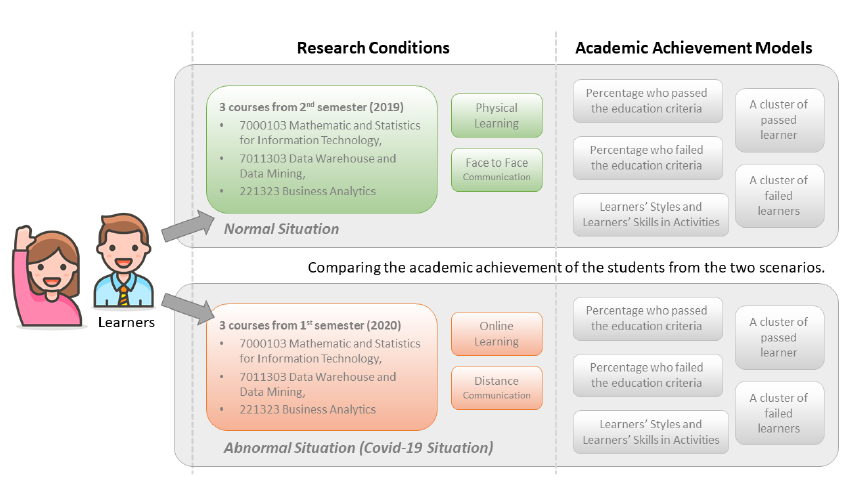
Fig. 1. Conceptual idea and research